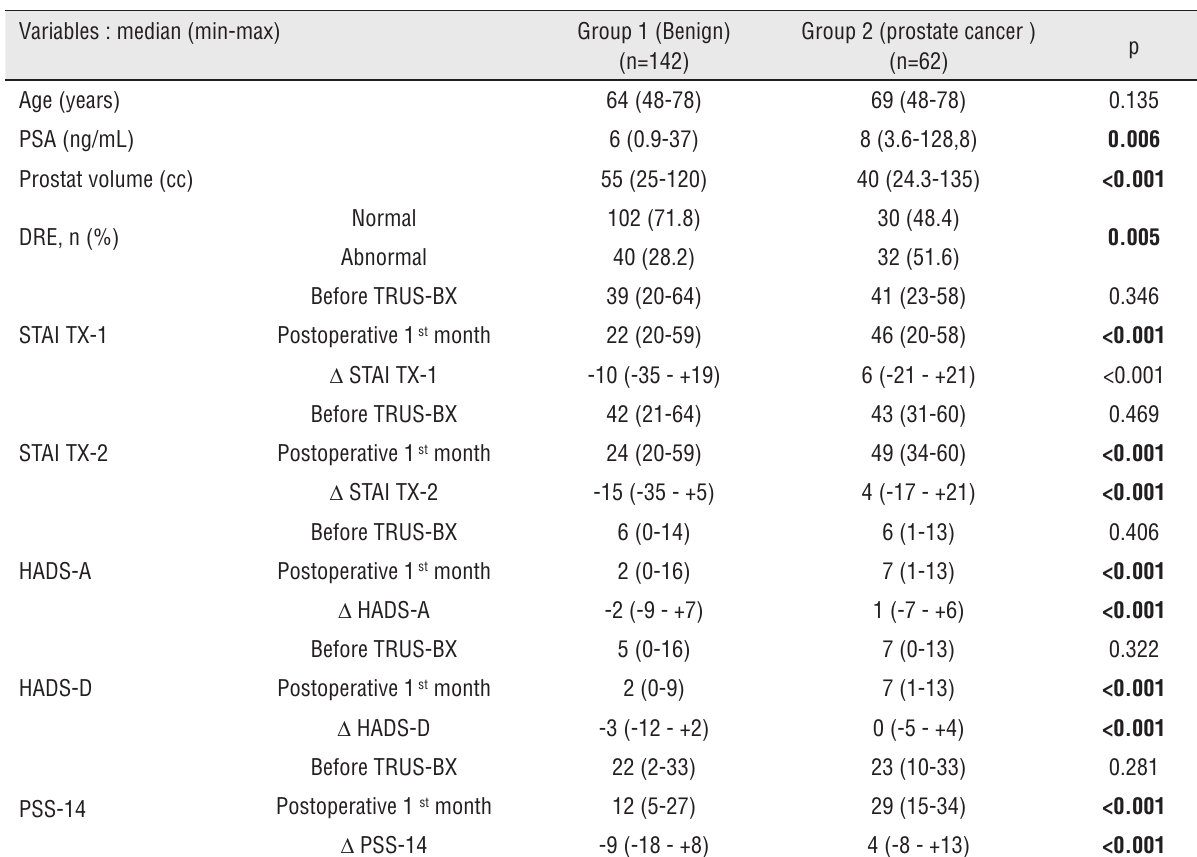
Table 3 - Demographic data and questionnaire results of the benign and prostate cancer groups according to histopathological examination results after